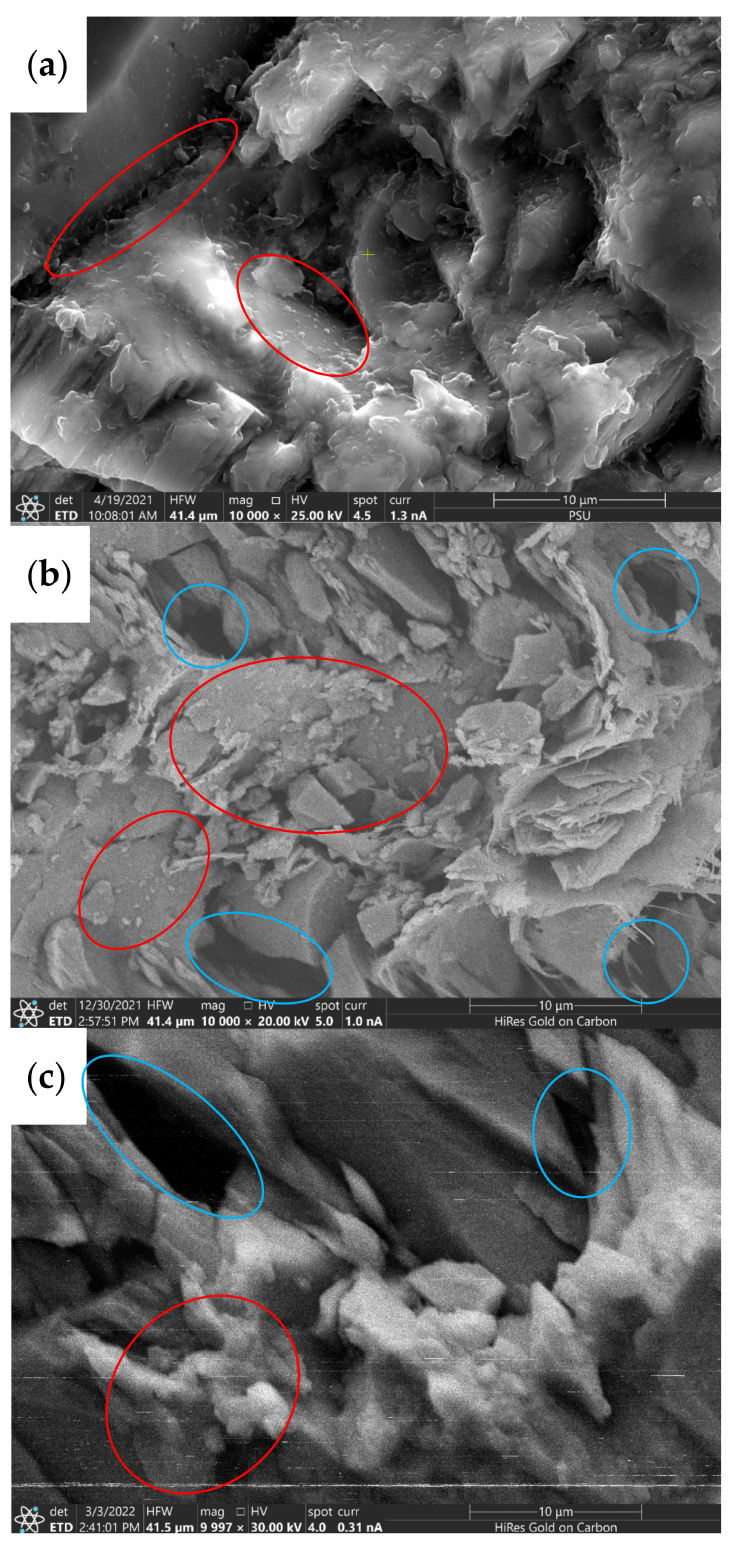
Figure 1. SEM of samples: ( a ) IEKEV2517, ( b ) IEKEV5602, ( c ) IEKEV5601. Red ovals show the places of colloids and small particles accumulation. Blue ovals show large visible